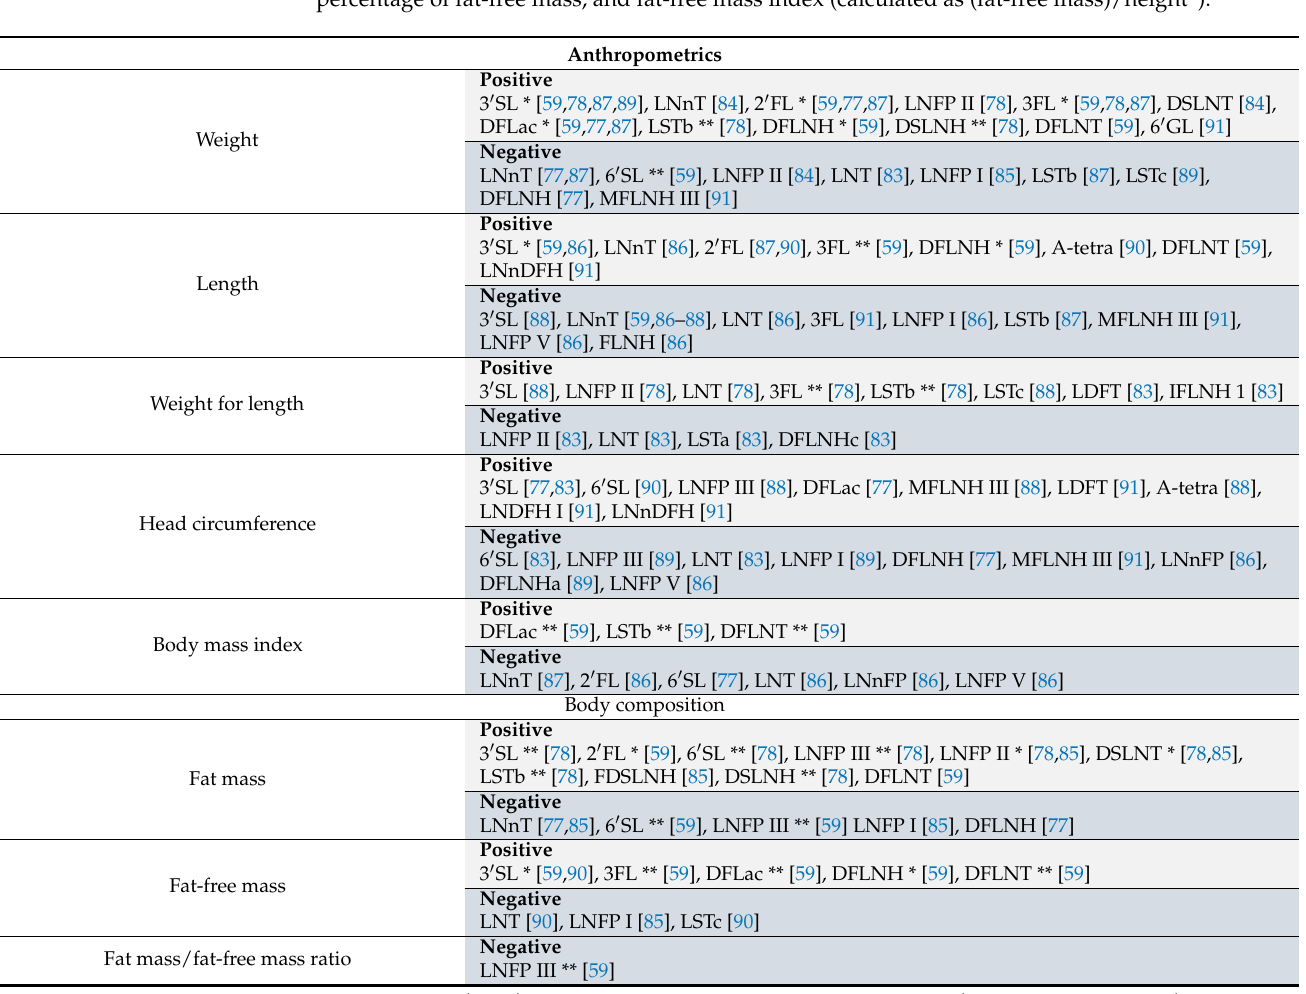
Table 1. Summary of associations between HMOs and infant growth outcomes. Weight includes growth outcomes of weight z score (weight compared to a standard of the same sex), change in weight z score, weight for age z score (weight compared to a standard of the same age and sex), and change in weight for age z score; length includes length z score, change in length z score, length for age z score, and change in length for age z score. Weight for length includes both weight for length z score (weight compared to a standard of the same length and sex) and change in weight for length z score. Head circumference includes head circumference z score, change in head circumference z score, head circumference for age z score, and change in head circumference for age z score. Body mass index includes growth outcomes of body mass index and body mass index for age z score. Fat mass includes fat mass, percentage of fat mass (weight of body fat), and fat mass index (calculated as (fat mass)/height 2 ). Fat-free mass includes fat-free mass (weight of body par that do not contain fat), percentage of fat-free mass, and fat-free mass index (calculated as (fat-free mass)/height 2